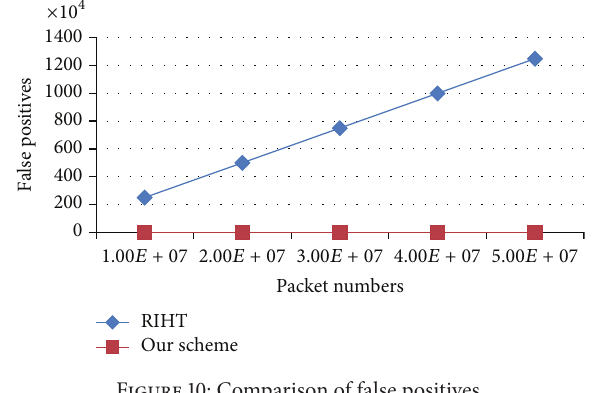
Figure 10: Comparison of false